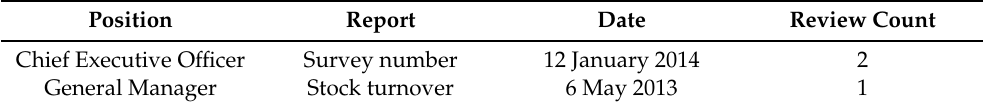
Table 3. Analyzed Log